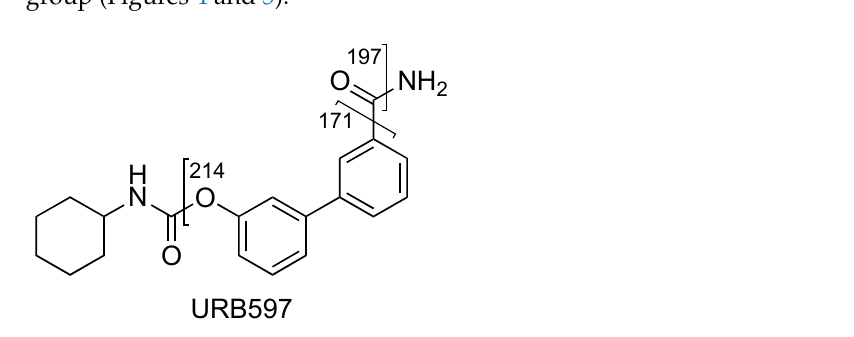
Figure 4. Representation of the collisional-induced fragment ions of URB597 compound.